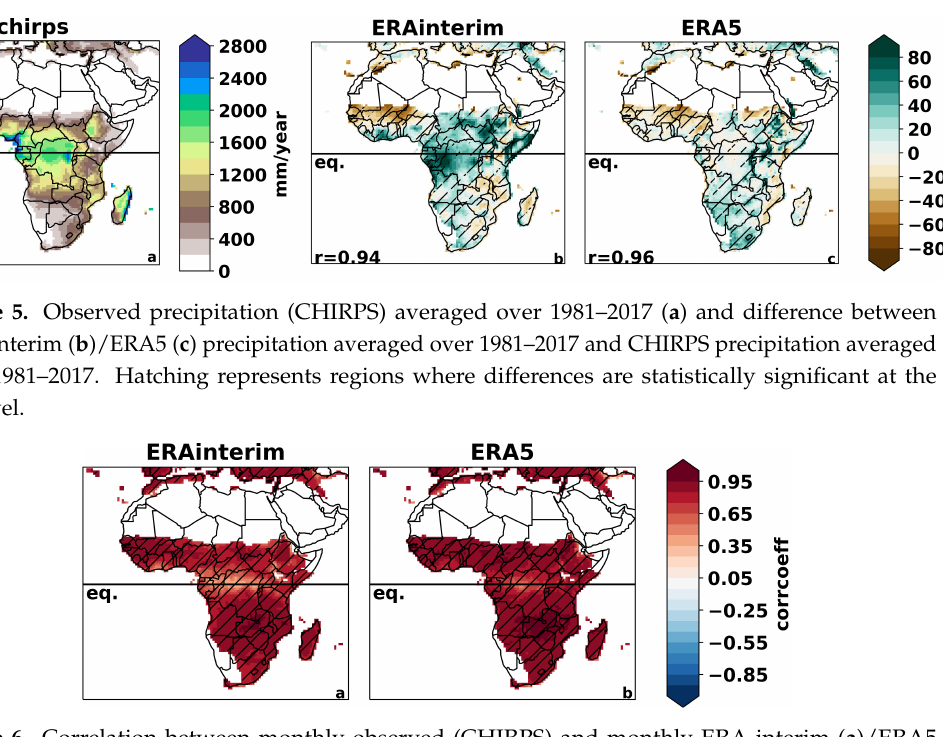
Figure 6. Correlation between monthly observed (CHIRPS) and monthly ERA-interim ( a )/ERA5 ( b ) precipitation from 1981–2017. Hatching represents regions where correlation values are statistically significant at the 1%